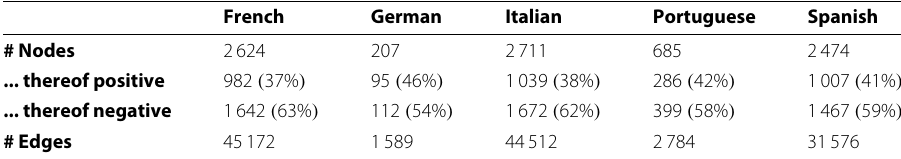
Table 3 Network